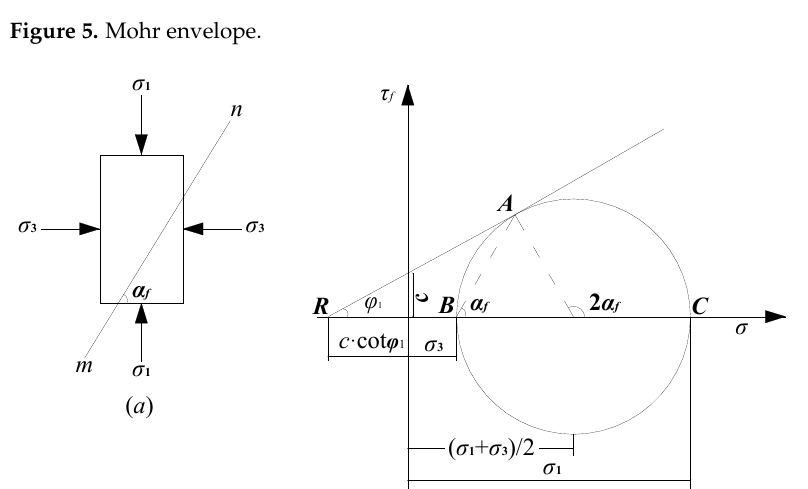
Figure 5. Mohr envelope.